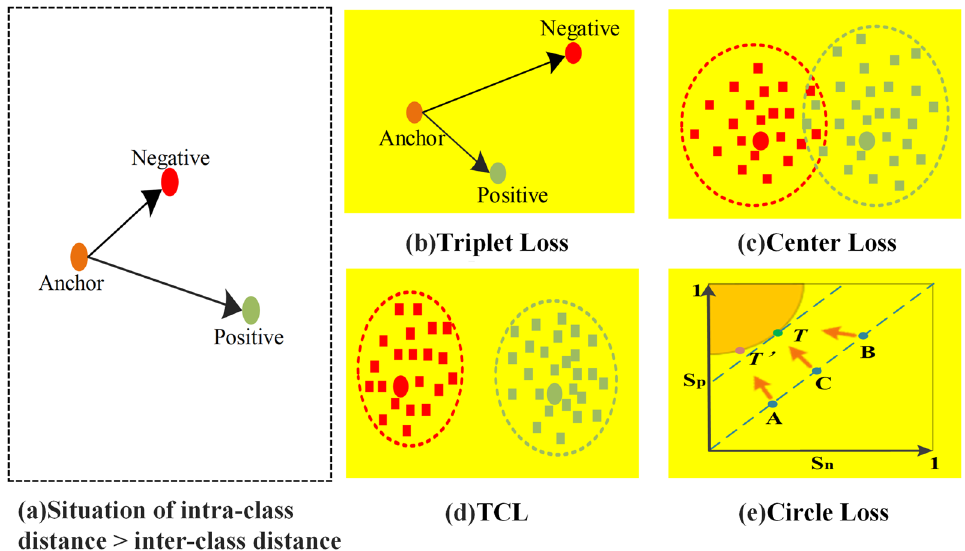
Figure 4. This is Features of different loss functions.